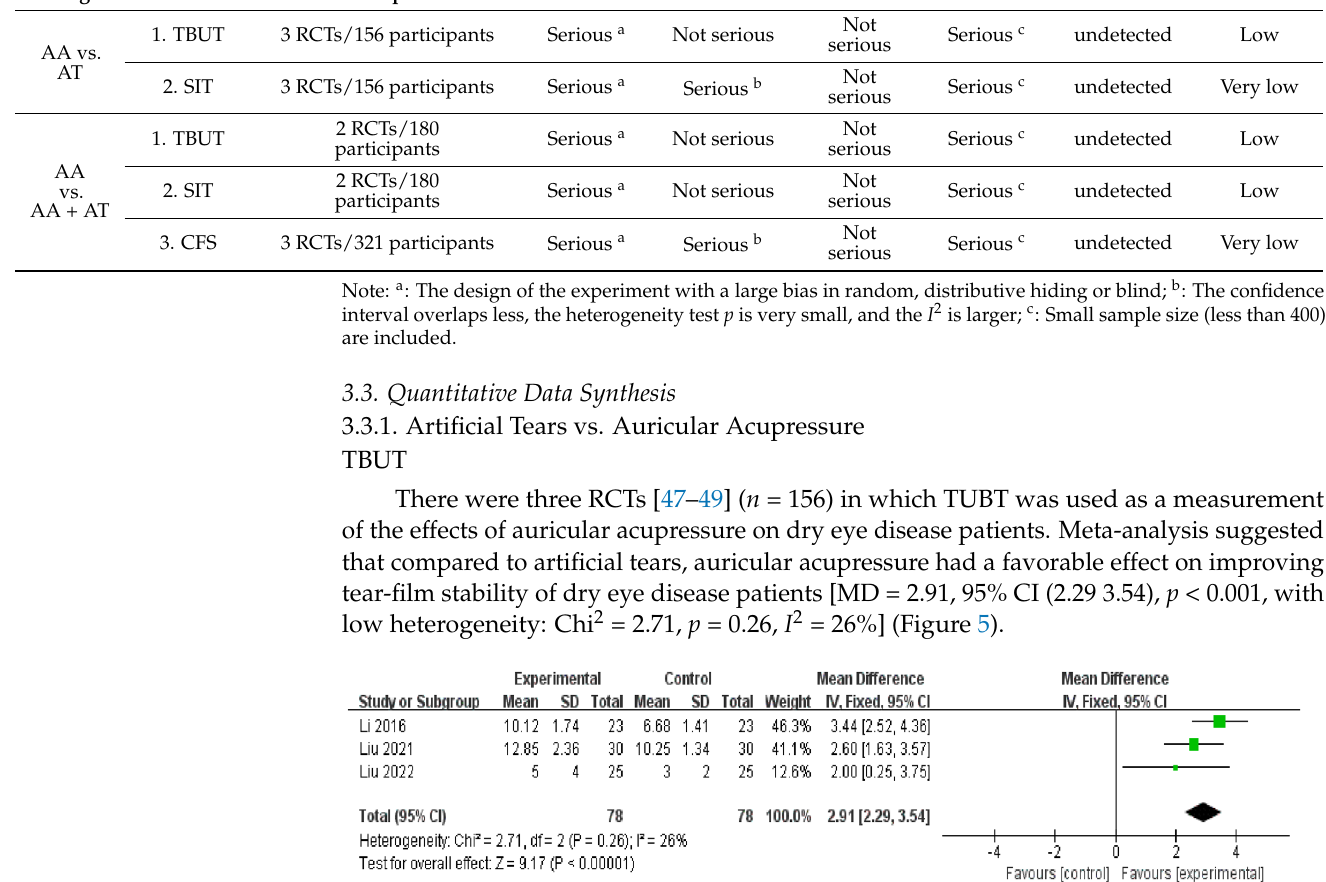
Table 2. Quality of evidence in included systematic reviews with GRADE.